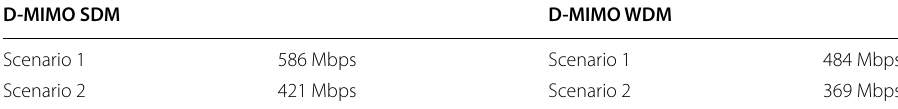
Fig. 16 Normalized downlink singular values for SDM,ξ1S1 and ξ2S1 for Scenario 1: spatially separated RX (solid lines) d1 100 cm, d2 70 cm, d3 70 cm, Scenario 2: (dashed lines) and ξ1S2 and ξ2S2 for Scenario 2: = = = co-located RX:d1 50 cm, d2 5 cm, d3 35 cm = = = Table 2 Throughput evaluation of D-MIMO set-up in two different scenarios